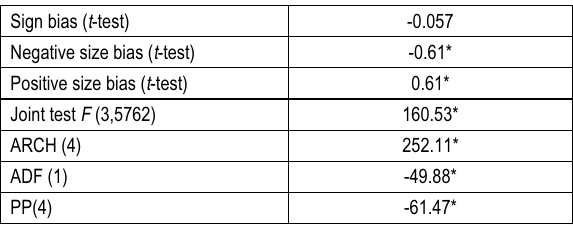
Table 2. Volatility specification tests for filtered